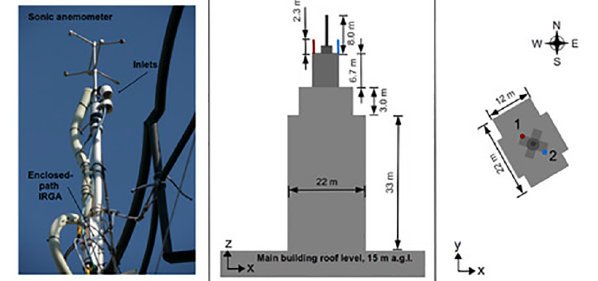
Figure 2. Left: a photo of one EC installation. Middle: a side view of the tower. Right: a plan view. See Nordbo et al. (2013) for more